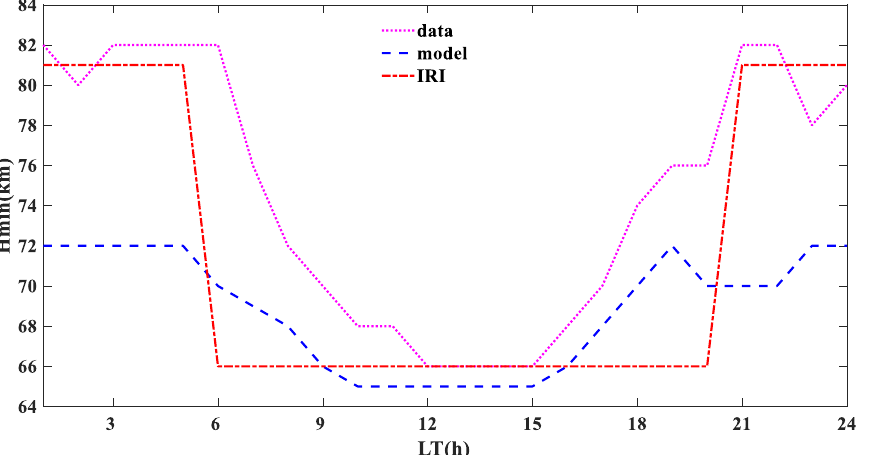
Figure 10. The height of the minimum electron density of the physical model, radar data, and IRI varies with the local time.